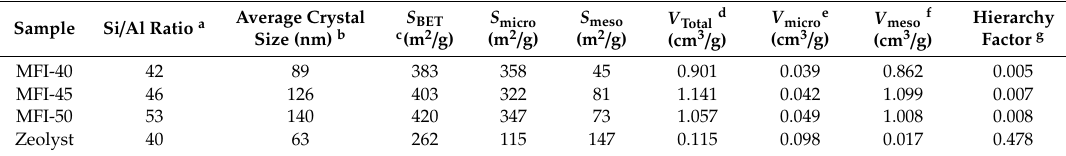
Table 1. Crystallite size, chemical composition, and textural properties for synthesized H-ZSM-5 and Zeolyst samples.